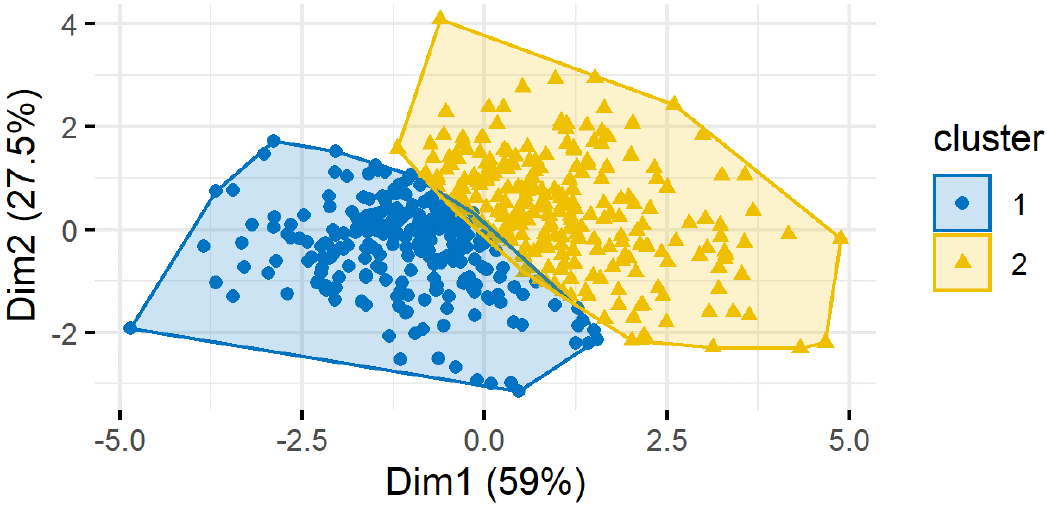
Figure 1. K − Medoid Method Clustering with k = 2 clusters.